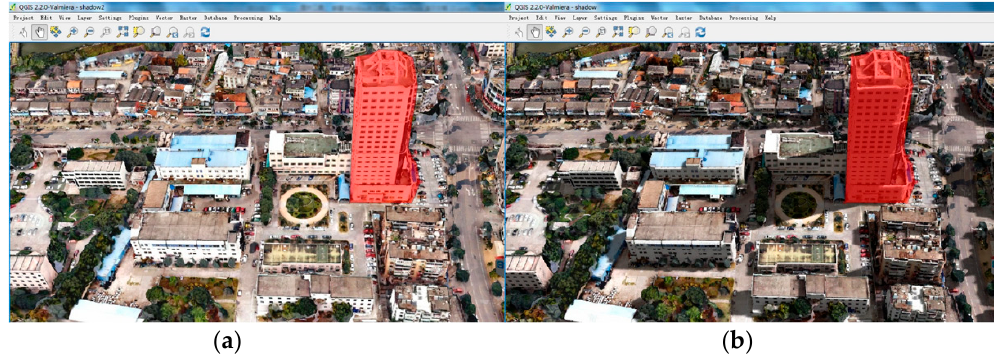
Figure 15. Incorporating computer-generated virtual effect into a 2.5D map ( a ) without shadow effect; ( b ) with shadow